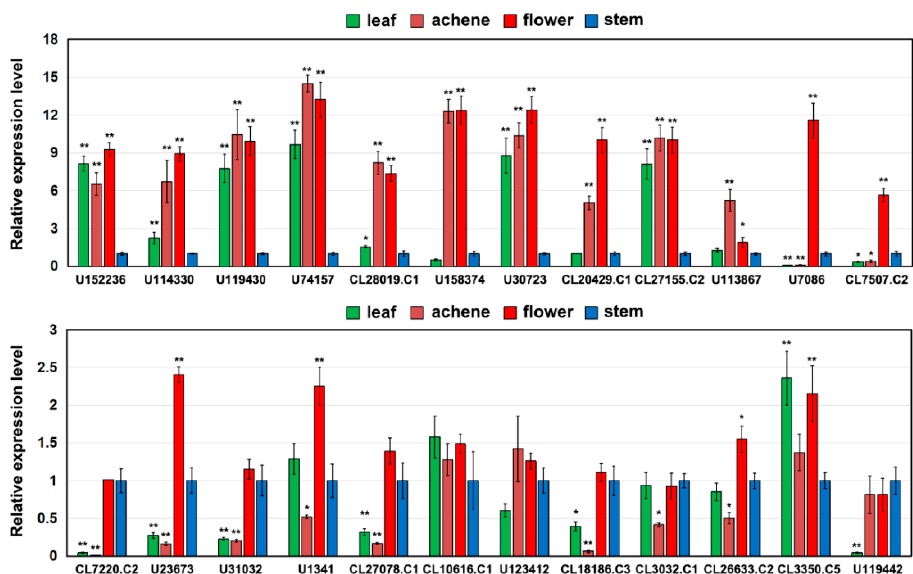
Figure 3. Expression analysis of 24 AaMADS genes in different tissues, including stems, leaves, flowers, and achene by qPCR. The AaActin gene was used as an internal control, and the transcript level in stems was set as 1.0. Asterisks indicate significant differences in gene expression levels between other tissues and the stem (* p < 0.05; ** p < 0.01; Student’s t -test). Error bars represent the SE ( n =